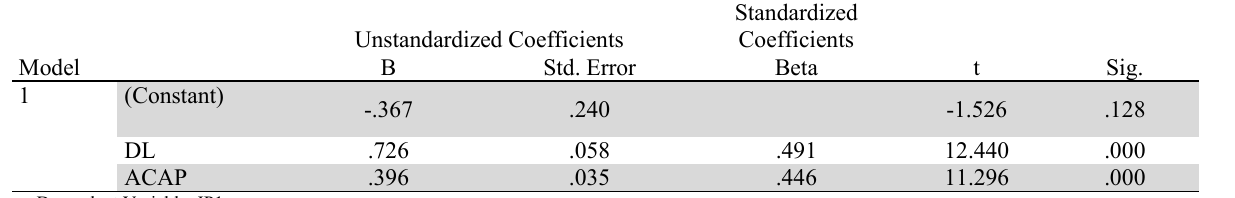
Coefficients of ACAP, DL and IP